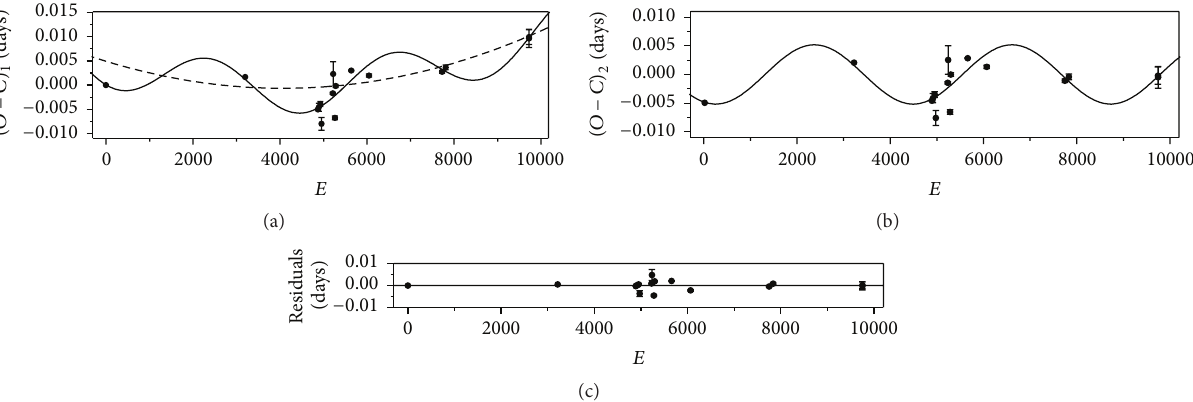
Figure 1: The (𝑂 − 𝐶) 1 values of V921 Her from the linear ephemeris of (2) are presented in (a). The solid line in the panel refers to the combination of an upward parabolic variation and a cyclic change. The dashed line represents the upward parabolic variation which reveals a continuous increase in the orbital period. In (b), the (𝑂 − 𝐶) 2 values with the quadratic part in (3) removed are displayed, where a cyclic change is more clear to be seen. After both the parabolic change and the cyclic variation are removed, the residuals are plotted in (c).